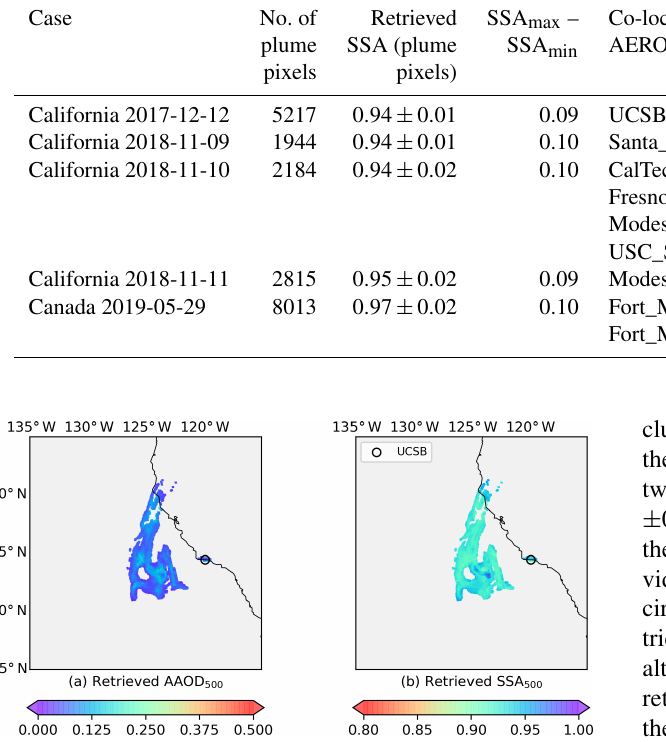
Figure 10. SVR retrievals for the Californian fire event on 12 De- cember 2017: (a) retrieved AAOD at 500nm; (b) retrieved SSA at